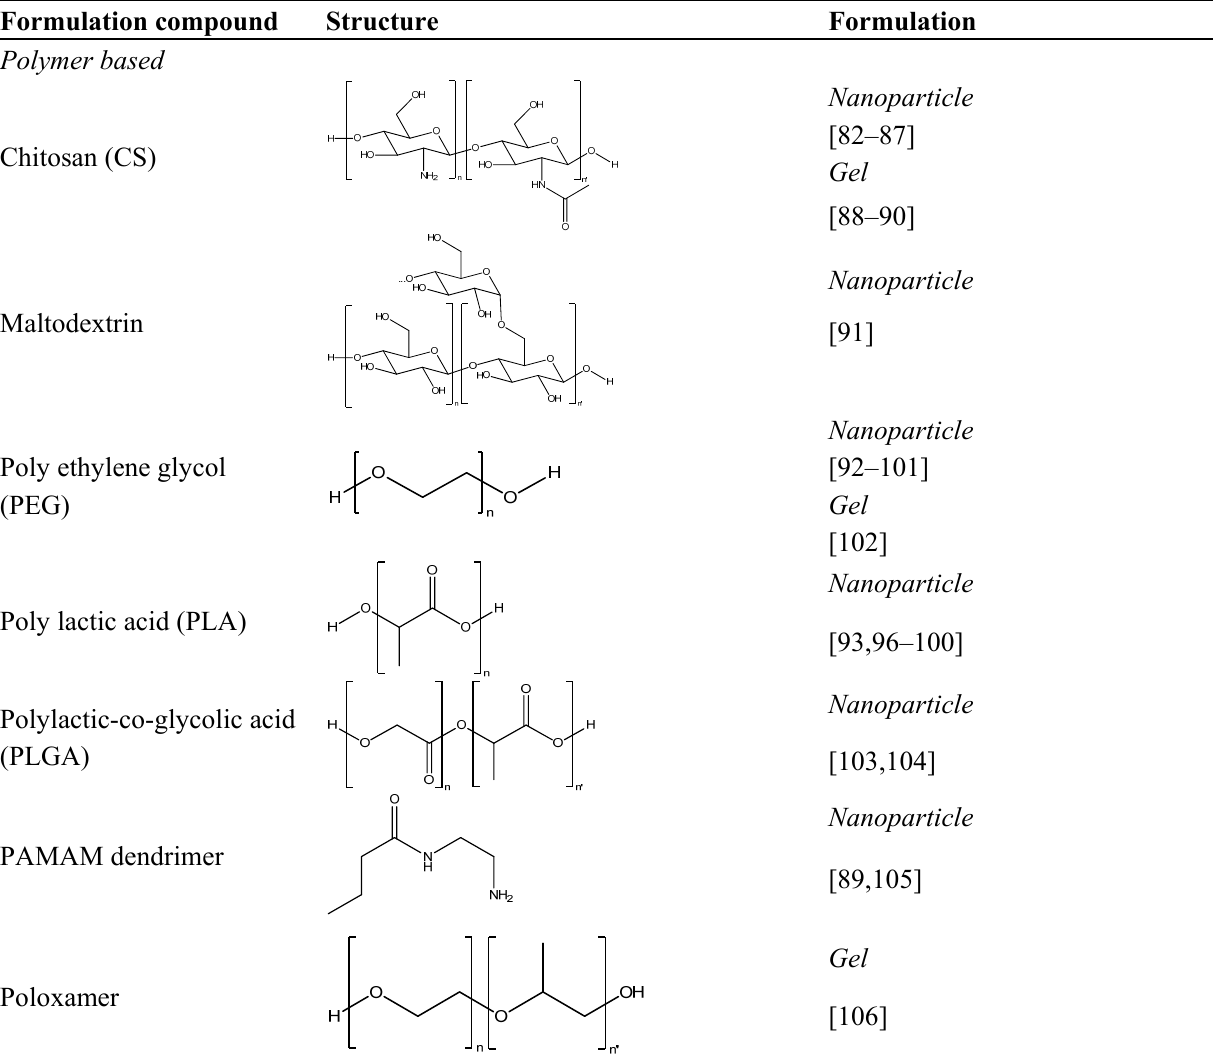
Table 2. Overview of the pharmacological formulations, both polymer based and lipid based, that increase the efficacy of nose-to-brain transport after intranasal